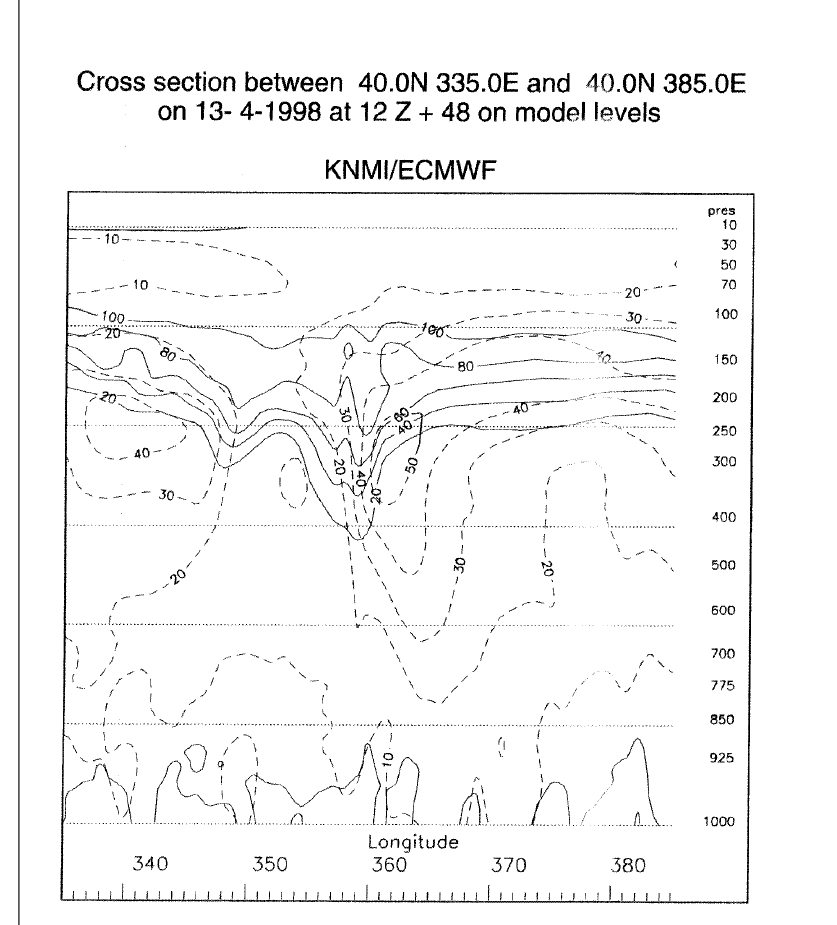
Fig. 8. Vertical cross section of the wind speed ( dotted lines , in m s ) 1 ) on 15 April 12 GMT along 40 (cid:176) N (which is the red line in Fig. 3b), with pressure as the vertical coordinate (in hPa), together with some isolines of PV ( solid lines , in PVU *10)